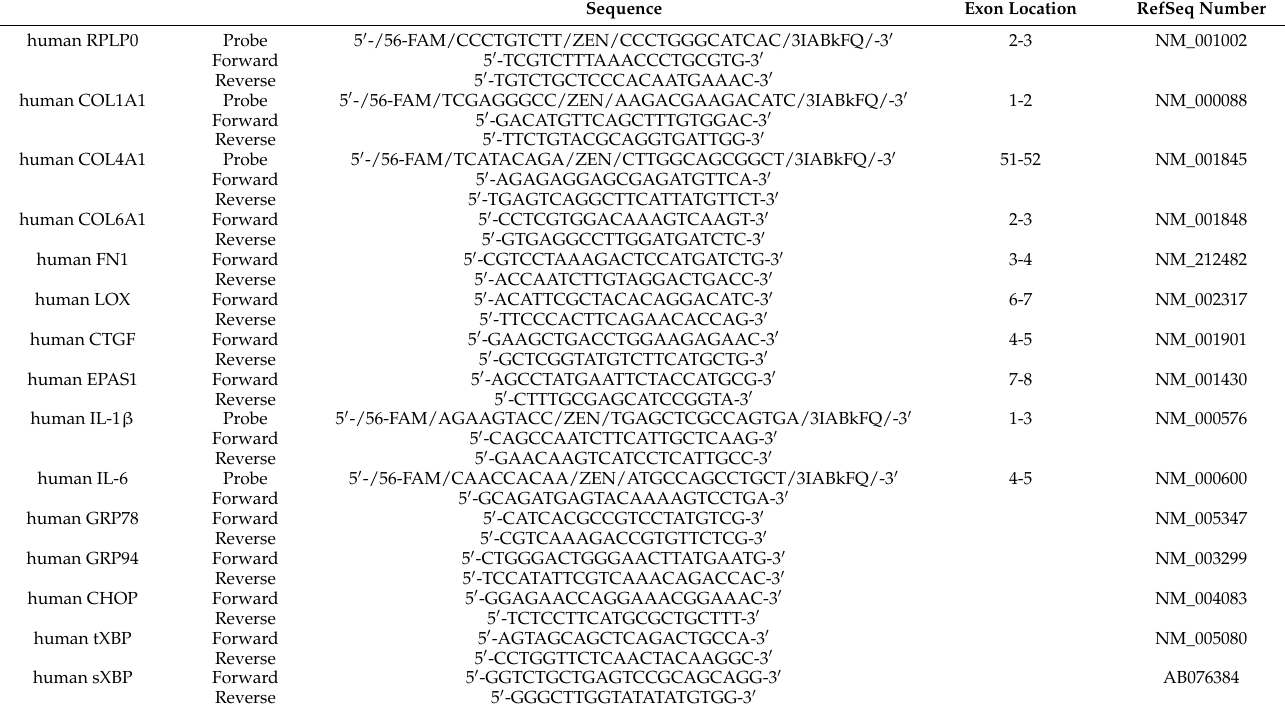
Table 1. The sequences of the primers and Taqman probes used in the present study. Sequence Exon Location RefSeq Number human